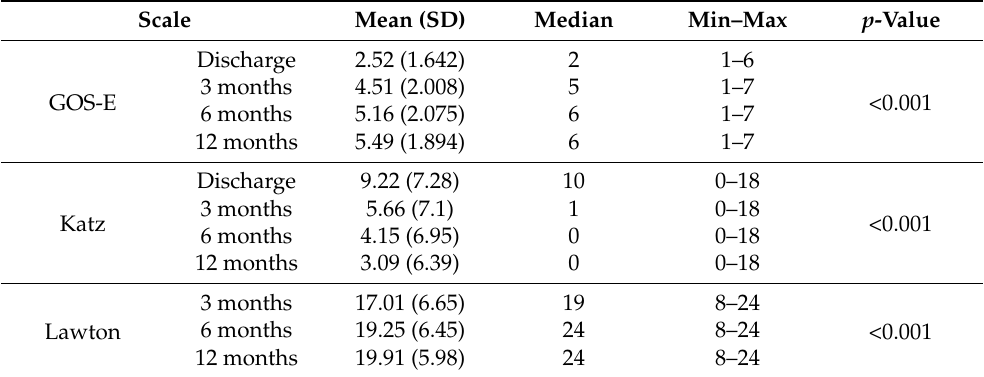
Table 2. Comparison of GOS-E, Katz and Lawton scale Index scores after trauma in severe TBI victims with focal